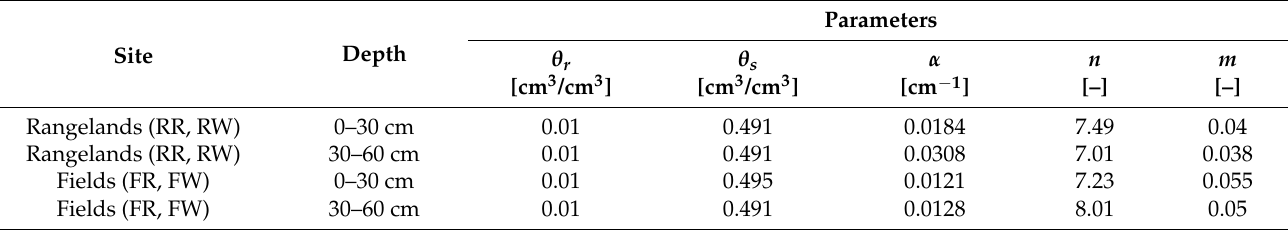
Table 3. Parameters of the van Genuchten model used in Equation